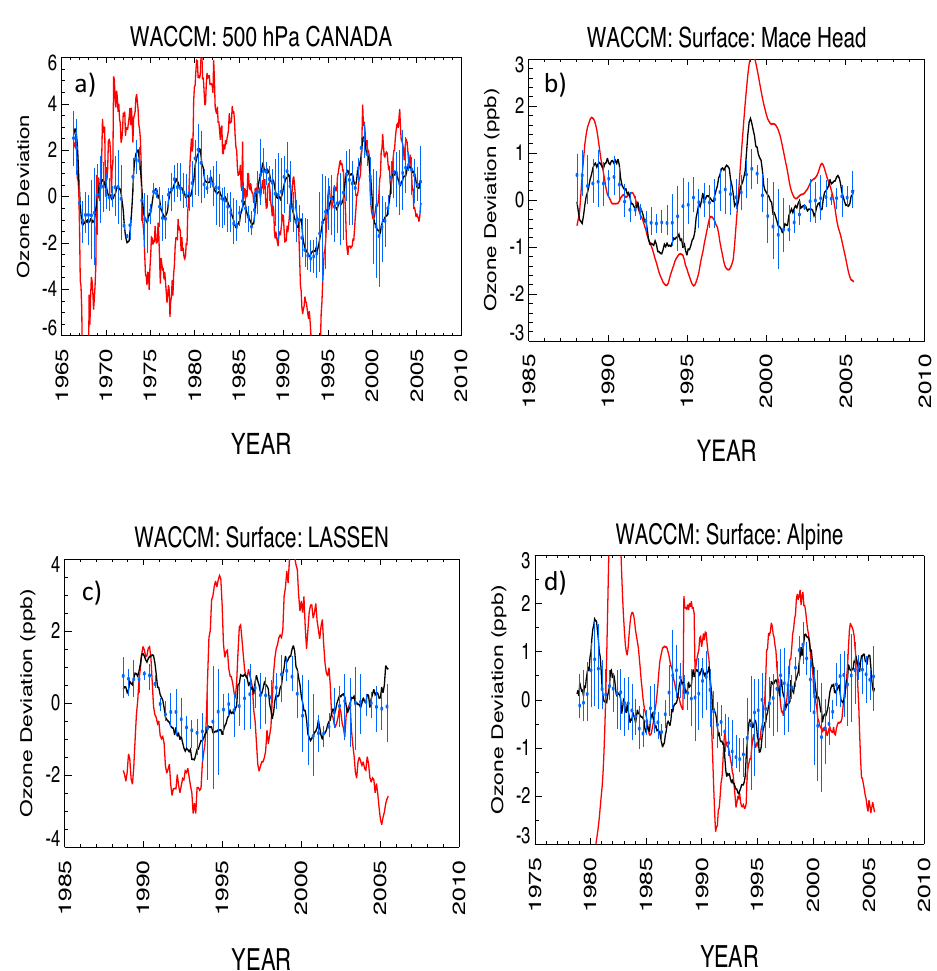
Figure 14. 12-month smoothed ozone deviations (ppb) for (a) the 500hPa Canadian ozonesondes and the surface sites at (b) Mace Head, (c) Lassen, and (d) the European Alps (note the different scales in each figure): detrended measurements (red), ensemble average detrended ozone (black), and the time variation of the first EOF (blue), where the vertical blue lines bracket the range of the EOF over the ensemble members and the blue dot gives the ensemble average EOF. In each case, ozone deviations are detrended against globally averaged methane over the common range of simulated and measured